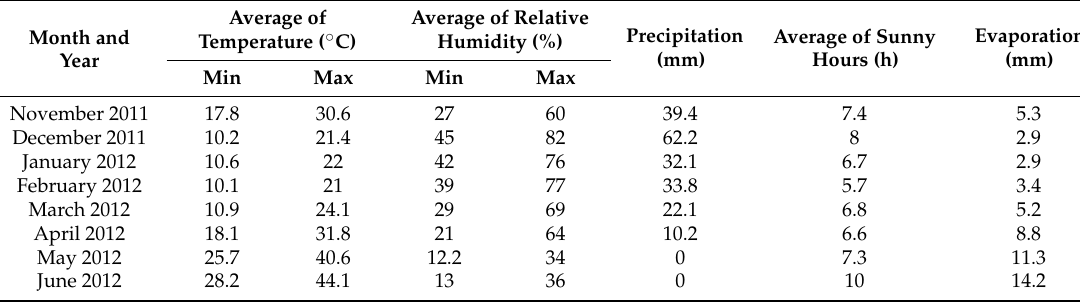
Table 4. Meteorological data during the experimental year (2011–2012) for growth and development of chamomile in Borazjan, Bushehr Province, Iran.